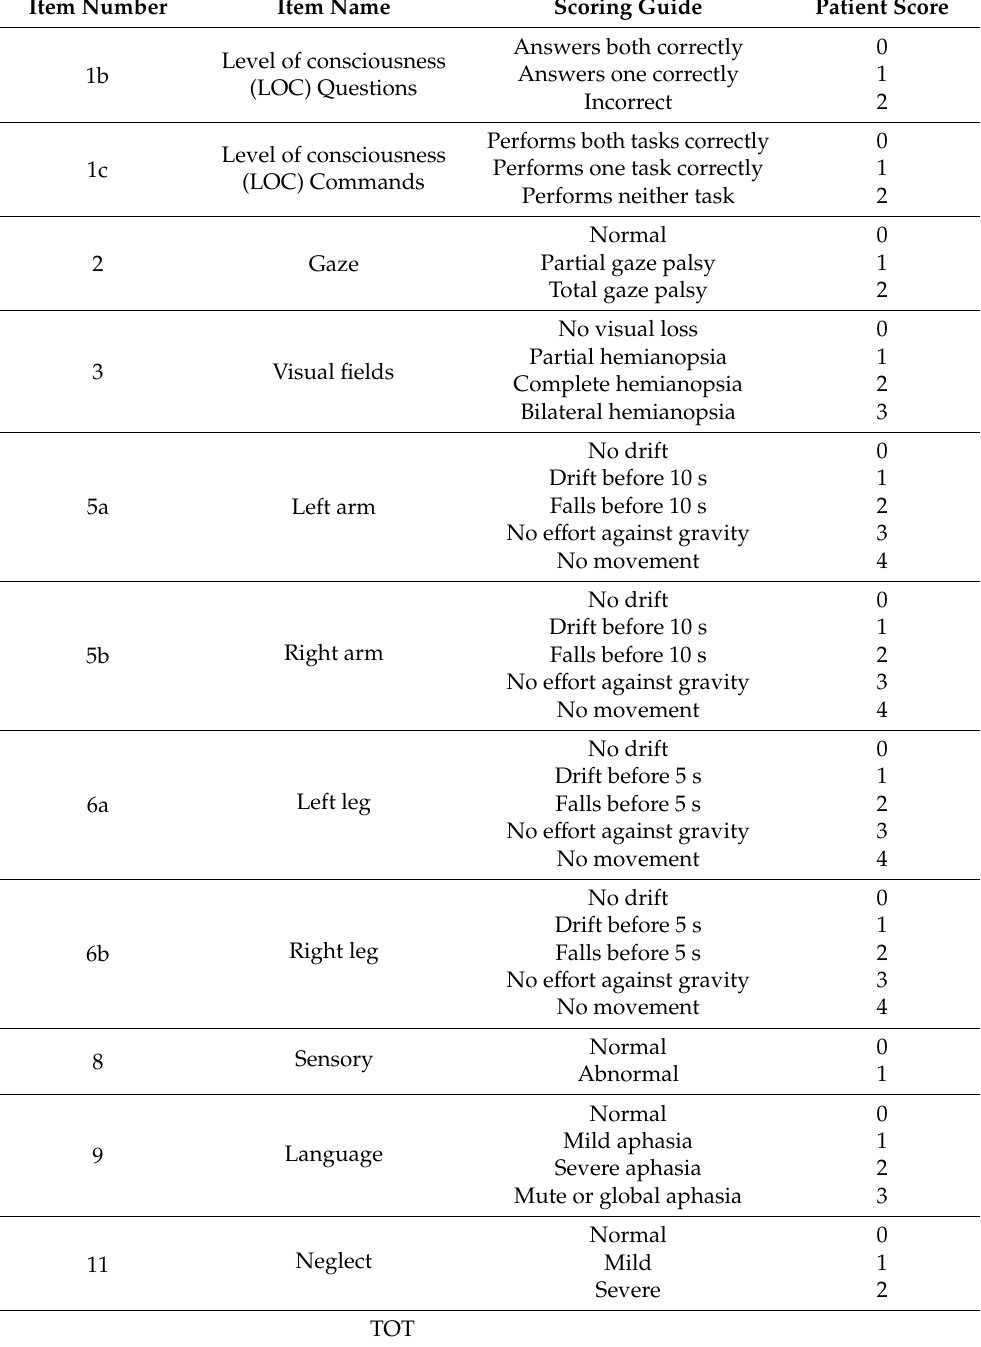
Table 3. Modified national institutes of health stroke scale (mNIHSS)